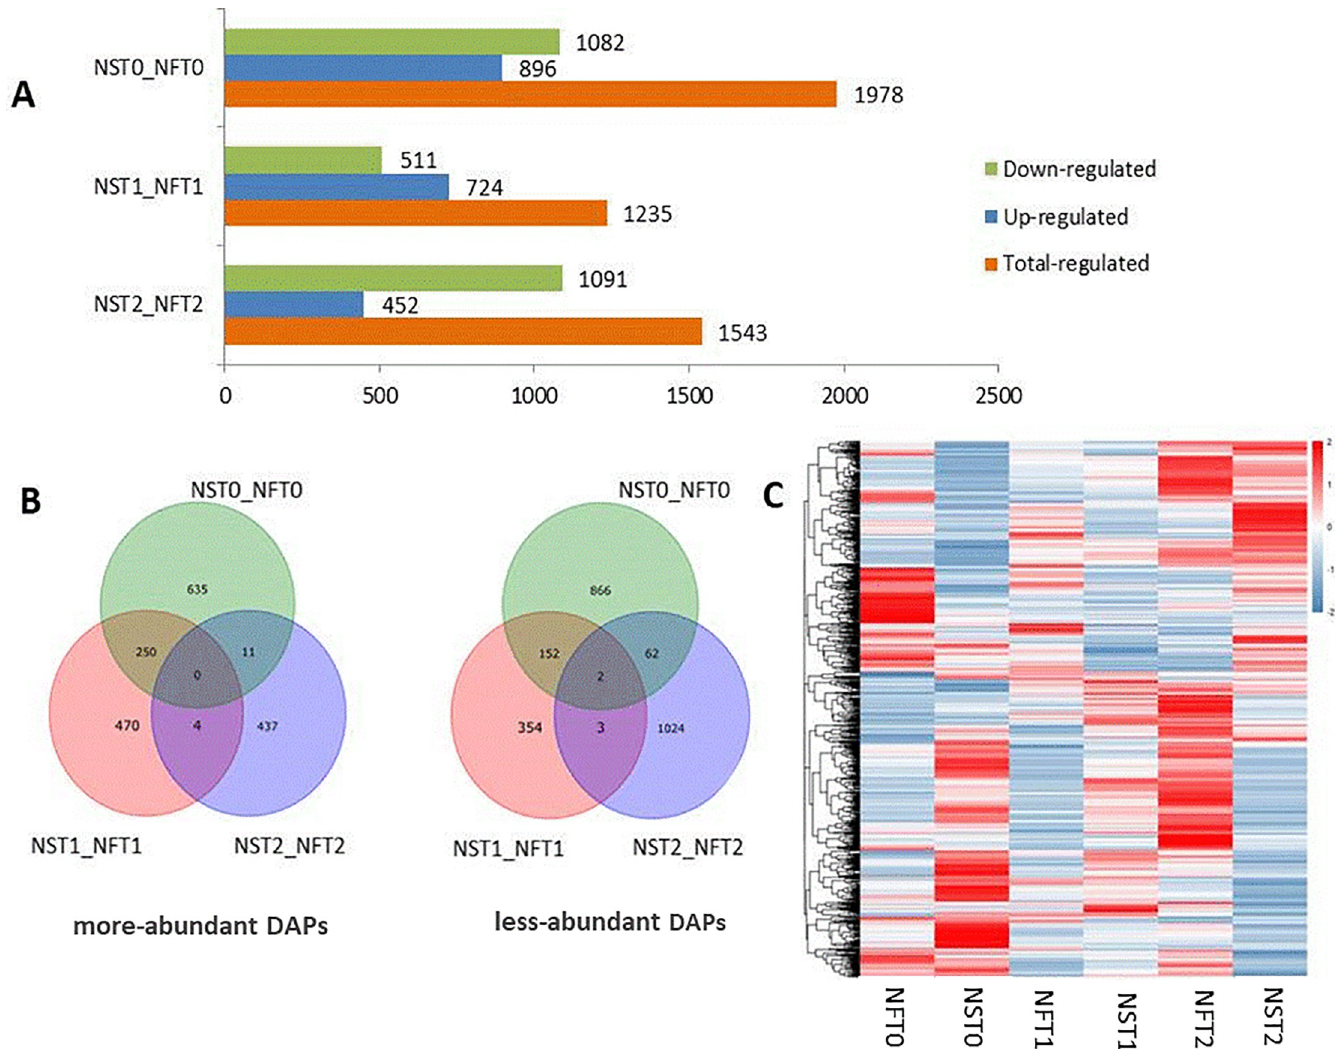
Fig 2. DAPs between two varieties at three cold-treatments of winter rapeseed ( Brassica napus ). (A) Column diagram of the DAPs. (B) Venn diagrams of the DAPs between two varieties, showing the numbers of the overlaps or unique DAPs (left: more-abundance, right: less-abundance). (C) The heat maps showing DAPs accumulation in each group, color change from red to blue represented abundant change from more to